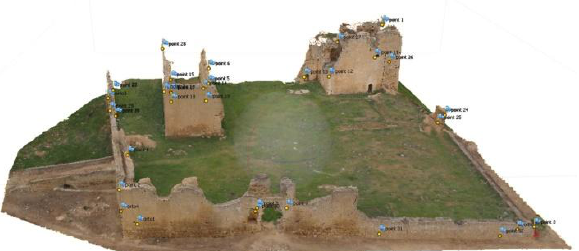
Figure 4: Villagarcía de Campos Castle’s 3D Model.